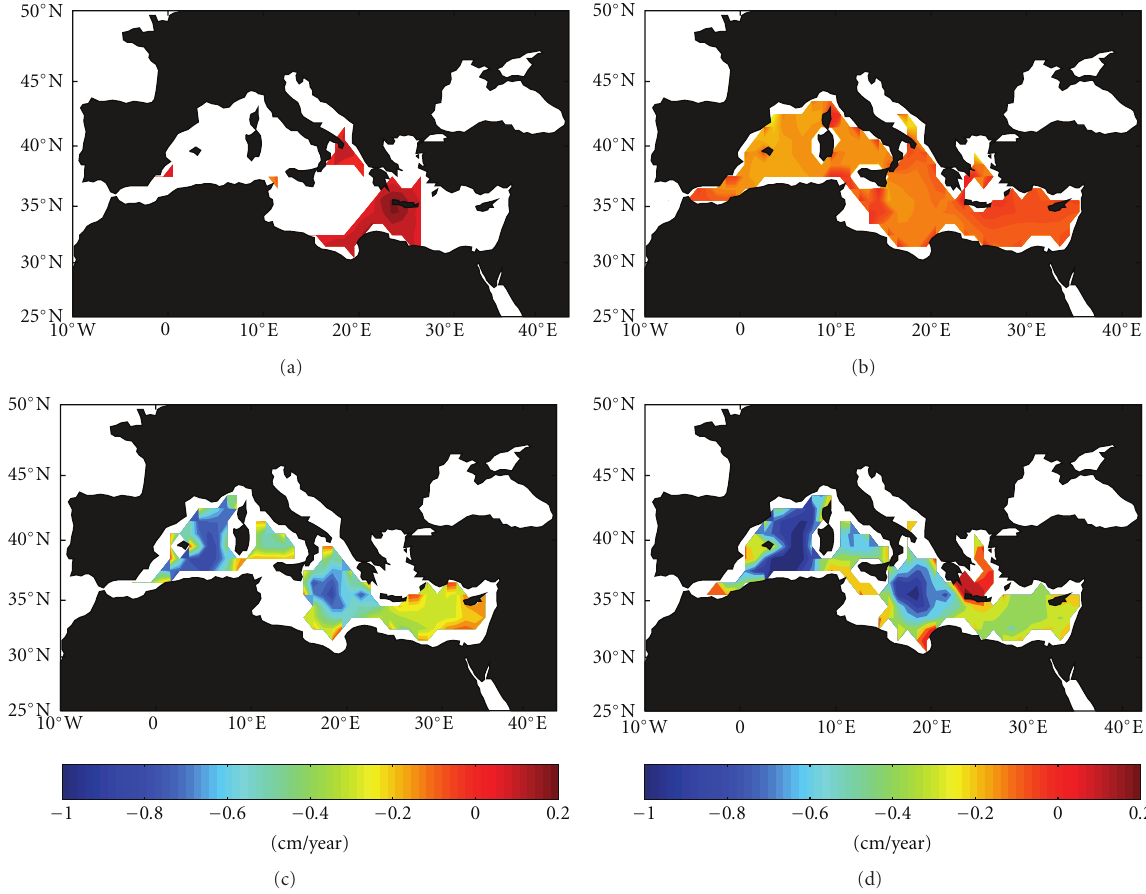
Figure 5: Spatial distribution of the steric sea level trend from the ECCO model data (93–09) for the di ff erent layers: (a) surface layer (0–150m), (b) intermediate later (150–600 m), (c) deep layer (600m–bottom), and (d) entire water column.